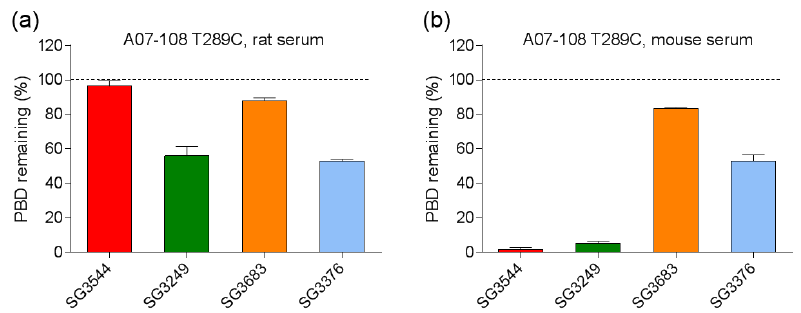
Figure 5. Quantification of pyrrolobenzodiazepine (PBD) loss from antibody-drug conjugates (ADCs)